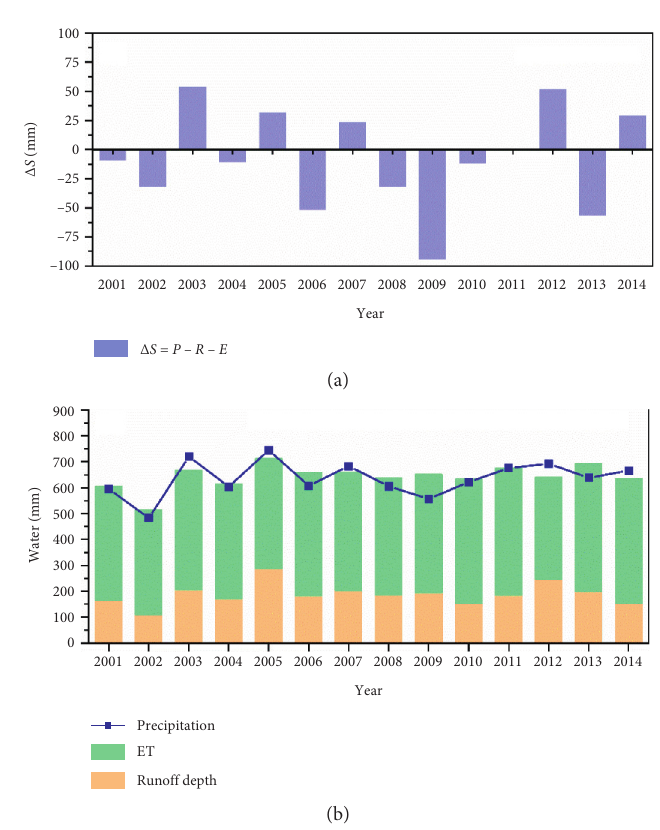
Figure 2: Water budget changes and correspondence between ETand precipitation by TRMM and runoff depth in the upper Taohe River basin during 2001–2014.